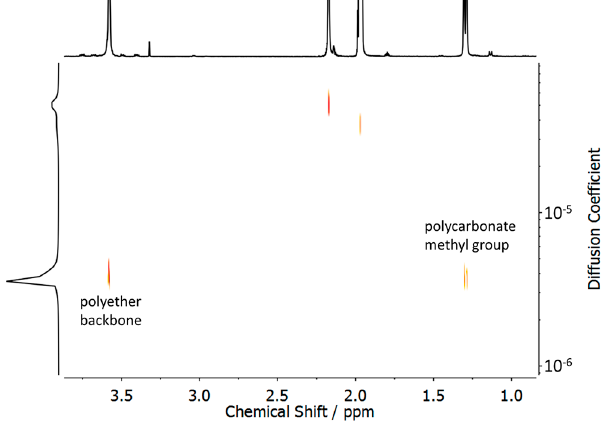
Figure 1 . 1 H - DOSY-NMR spectrum (CD 3 CN, 400 MHz) of mPEG 113 - b -PPC 49 (Table 1, sample 3).